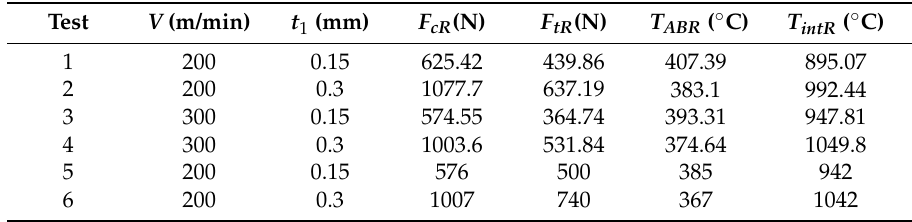
Table 2. Cutting condition parameters in the orthogonal machining of AISI 1045 steel ( w = 2 mm, α = − 7 ◦ , T 0 = 25 ◦ C) [21,28].